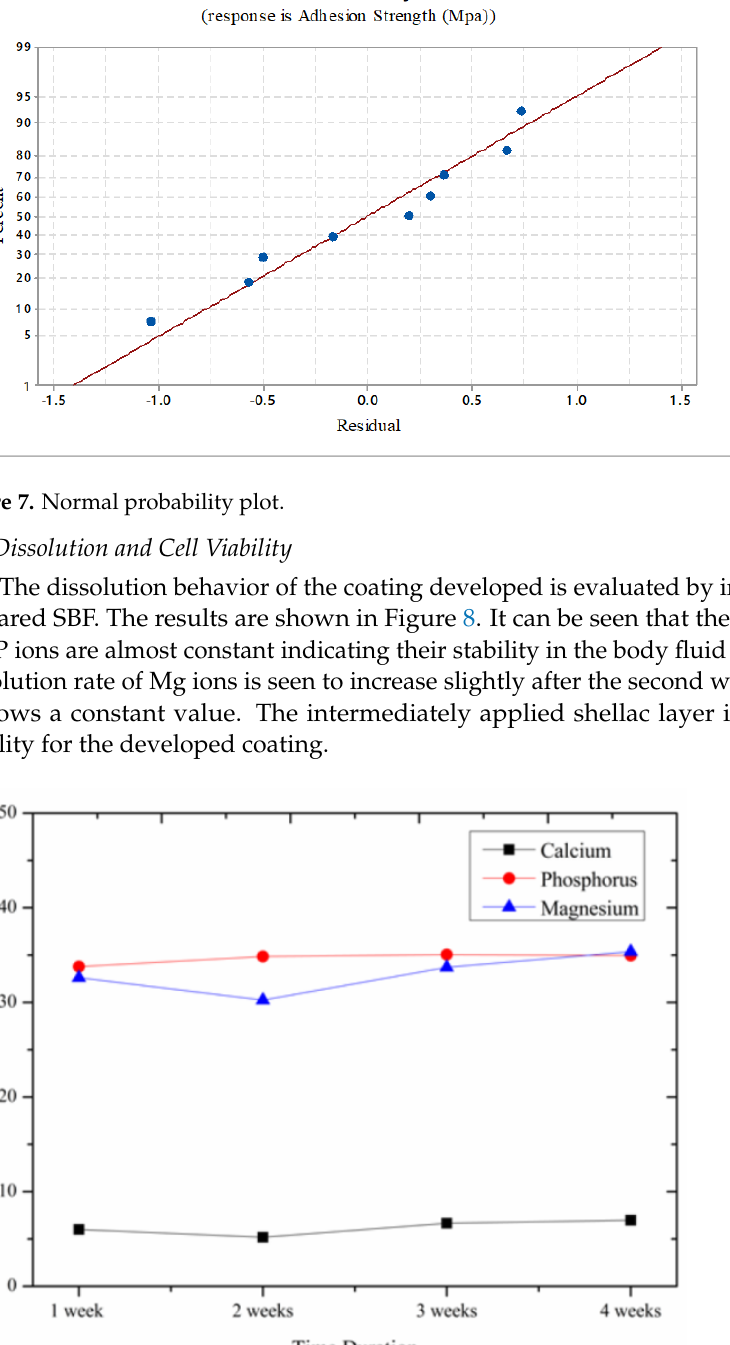
Figure 8. Change in ionic concentration.